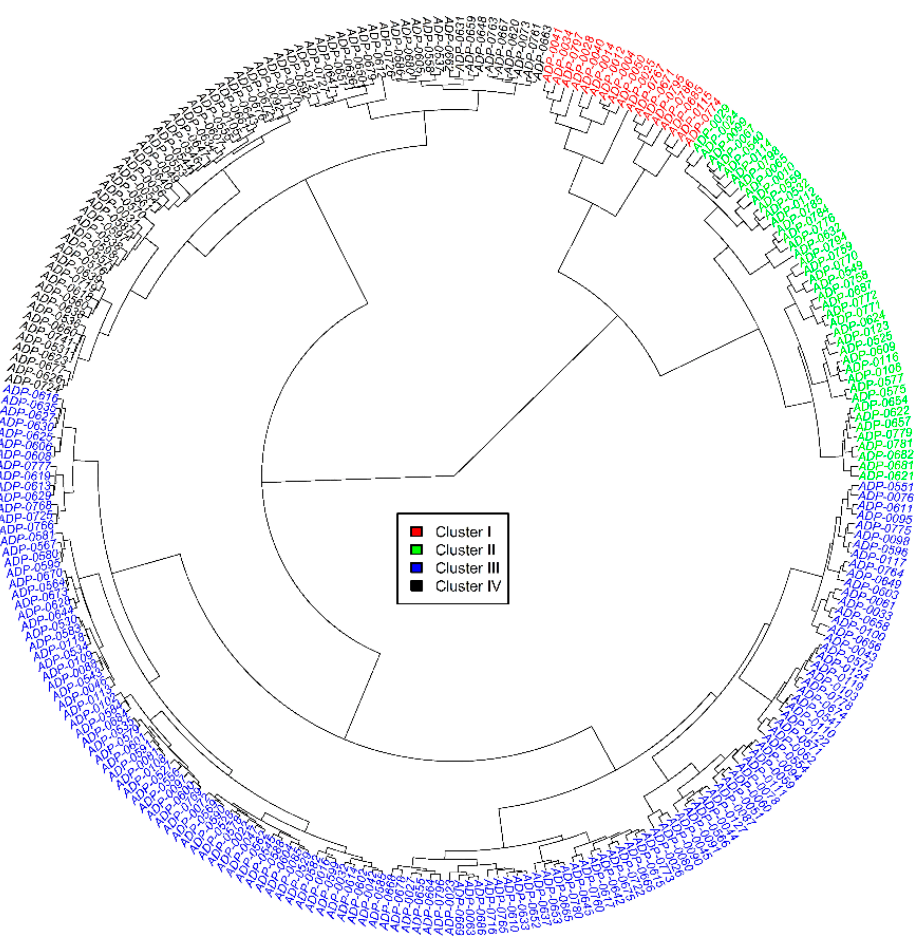
Figure 3. Phylogram of hierarchal clustering of 262 common bean genotypes grouped into four clusters based on response to Al-toxicity treatment. Euclidean distance was used for clustering based on seven quantitative root trait variables. Table 4. Intra- (diagonal values) and inter-cluster divergence (off-diagonal values) in 262 genotypes from the Andean common bean diversity panel (ADP) evaluated under Al-toxicity treatment based on pairwise generalized squared